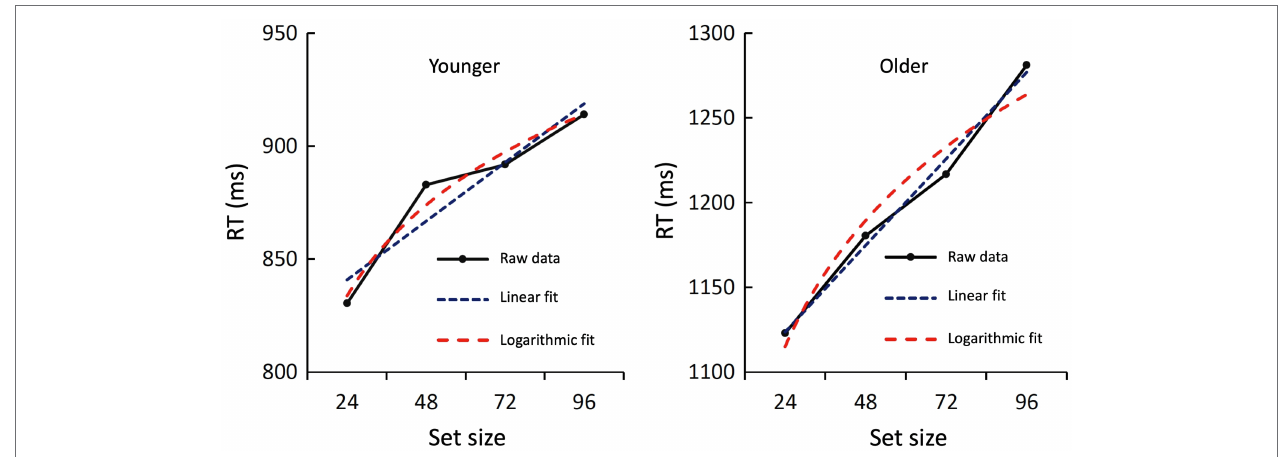
FIGURE 4 | Raw data and regression curves of the RTs during recognition. The averaged raw data of the younger ( left ) and older subjects ( right ) are shown in black, the linear regression curve in blue, and the logarithmic regression curve in red. Both fits were statistically significant or marginally significant (see text).